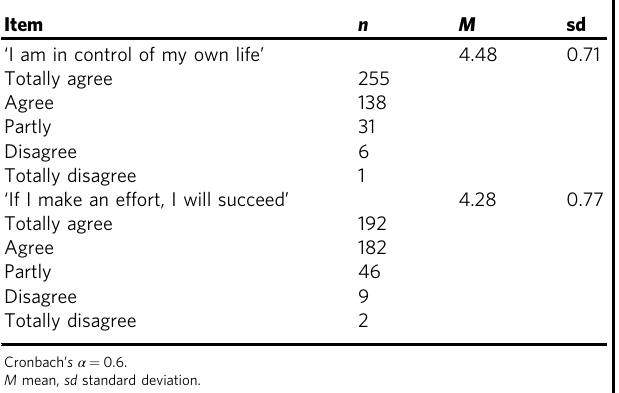
Table 4 Ef fi cacy-related attributes items and statistics.